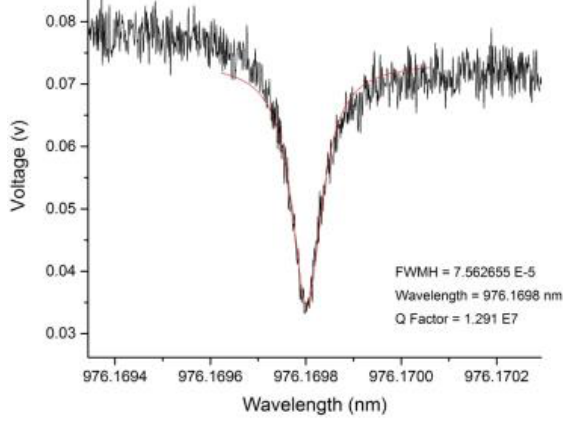
Figure 4. A representative resonance peak of the silica microspheres used as the WGM optical microcavities in the sensing experiments, showing a high quality factor device (black line—data, red line—Lorentzian fit) during testing in